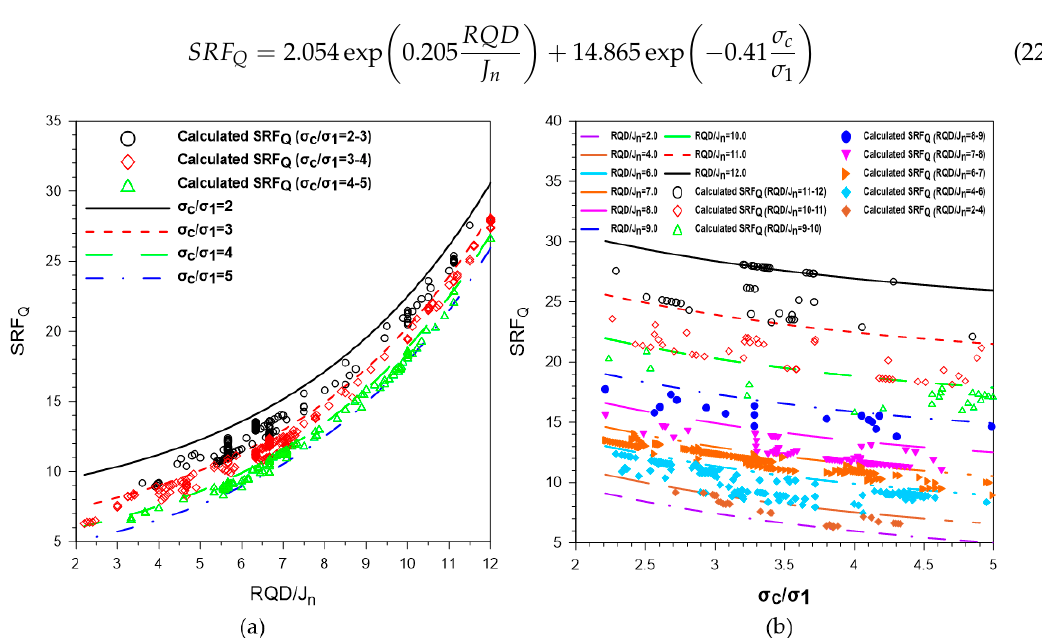
Figure 6. Relation of SRF Q with RQD / J n and σ c / σ 1 . ( a ) SRF Q vs. RQD / J n for different σ c / σ 1 values; ( b ) SRF Q vs. σ c / σ 1 for different RQD / J n values.